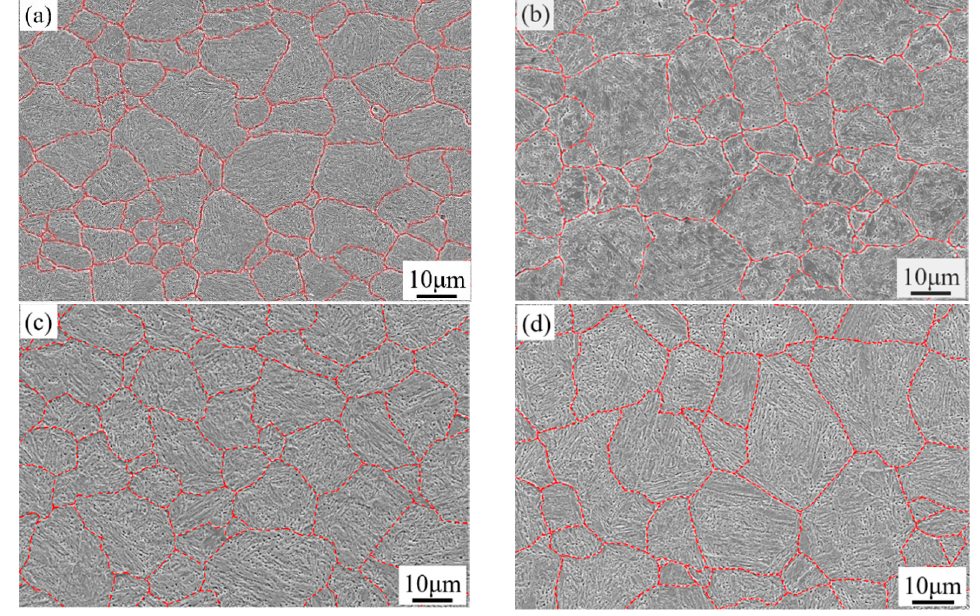
Figure 5. The prior austenite grain boundary of ( a ) 1000-P; ( b ) 1020-P; ( c ) 1040-P; and ( d ) 1060-P.